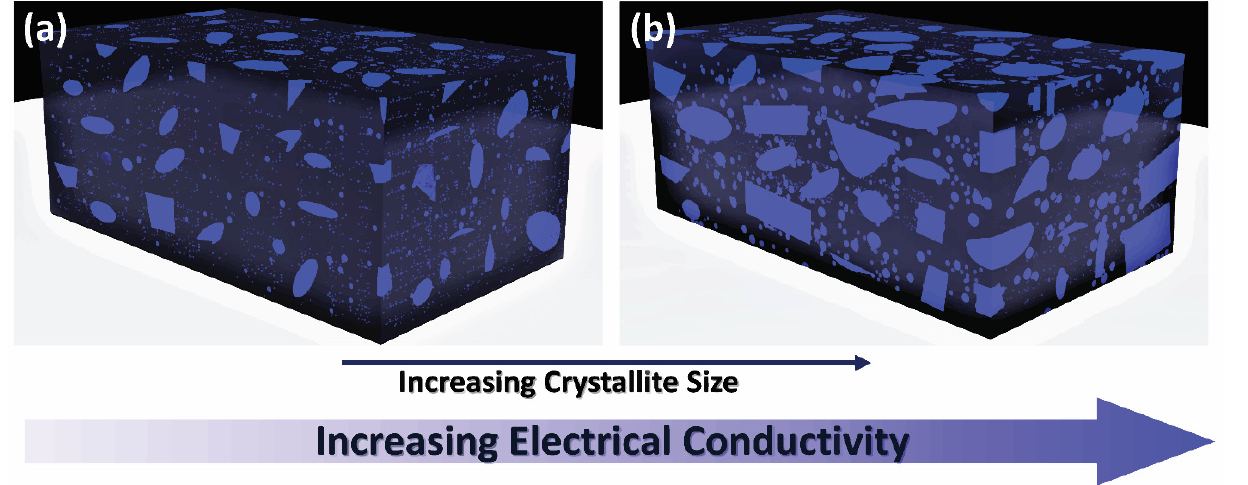
Figure 12. Schematic illustration of ( a ) a small crystallite size and ( b ) a large crystallite size in conjugated polymers [18]. The dark blue color represents the amorphous areas, and the light blue color represents the crystalline regions. A larger crystallite size is desirable for electrical conductivity enhancement and can be obtained by tuning the process parameters. ( a , b ) Reproduced with permission [18]. Copyright 2020, Wiley.